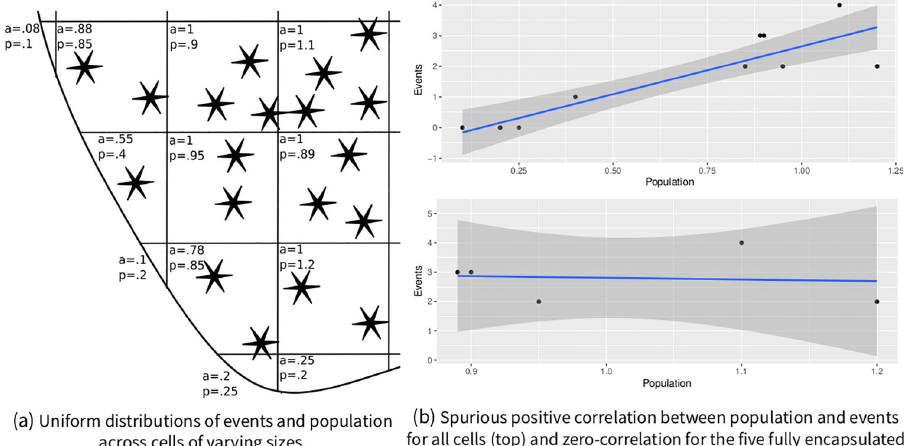
Fig 3. Illustration of areal confounding. On the left, example data is depicted featuring uniform spatial distributions for events and population (p) figures. As artificial cells of varying areas (a) are superimposed, higher event counts correlate with higher population figures (top right). When smaller border cells are excluded (or area is controlled for), this correlation disappears (bottom right).